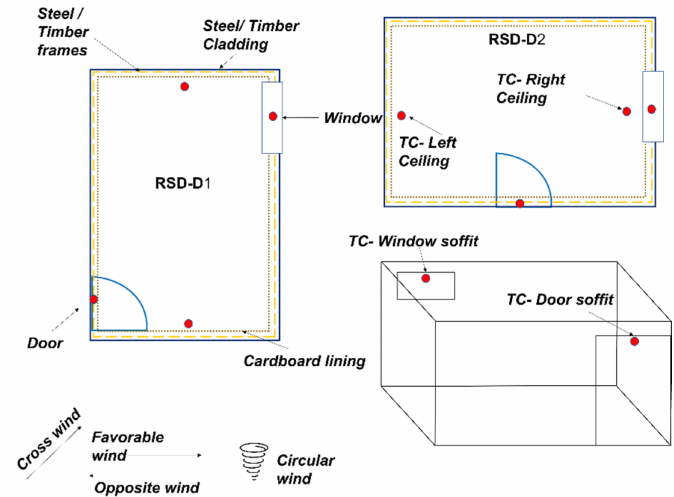
Figure 5. Instrumentation layout of an RSDs.